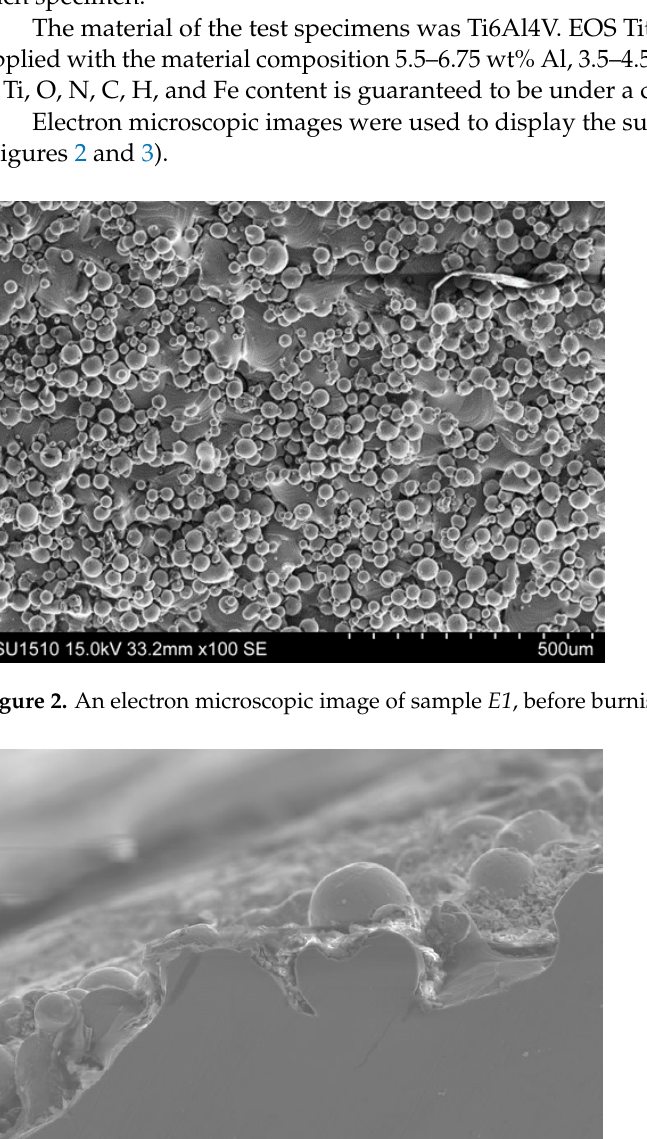
Table 1. The manufacturing parameters of the specimens. Code of Parameter Setup